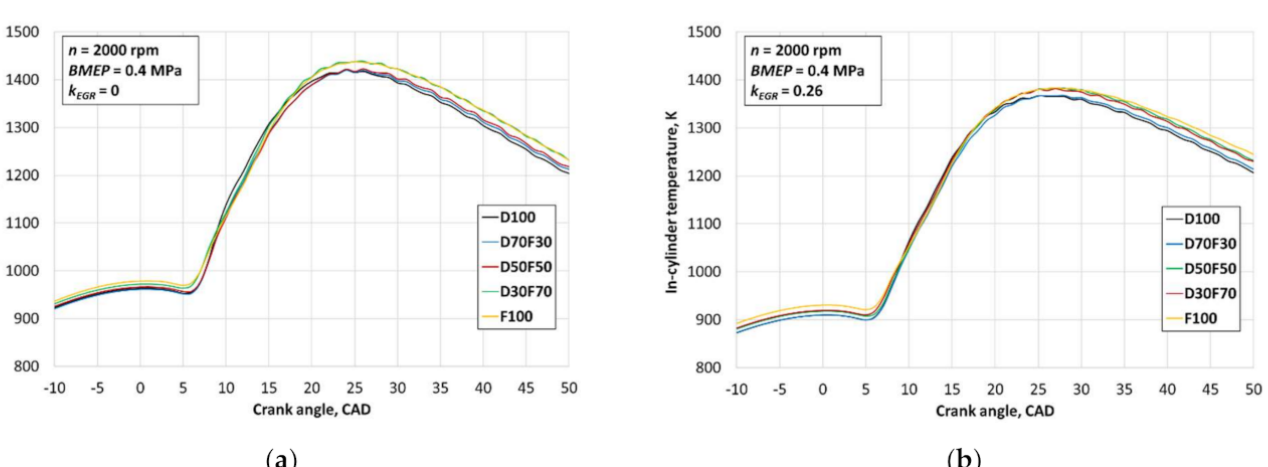
Figure 3. The in-cylinder rise in temperature, depending on fuel composition when ( a ) EGR is off and ( b ) EGR is on. The in-cylinder temperature graph (Figure 4) also confirms the fact that increasing the chicken fat concentration led to a longer combustion process. It was observed that, having increased the chicken fat concentration in the fuel to 100%, the in-cylinder temperature increased during the diffusion combustion phase from 1420 K to 1438 K with EGR off and from 1367 K to 1384 K with EGR on. This improved soot combustion, but more energy was evolved with exhaust gas. Gas of a higher temperature stayed in the cylinder, increasing the turbocharger pressure; therefore, the temperature at the end of the compression stroke was higher. This improved the ignition of the fuels that contained chicken fat additive.